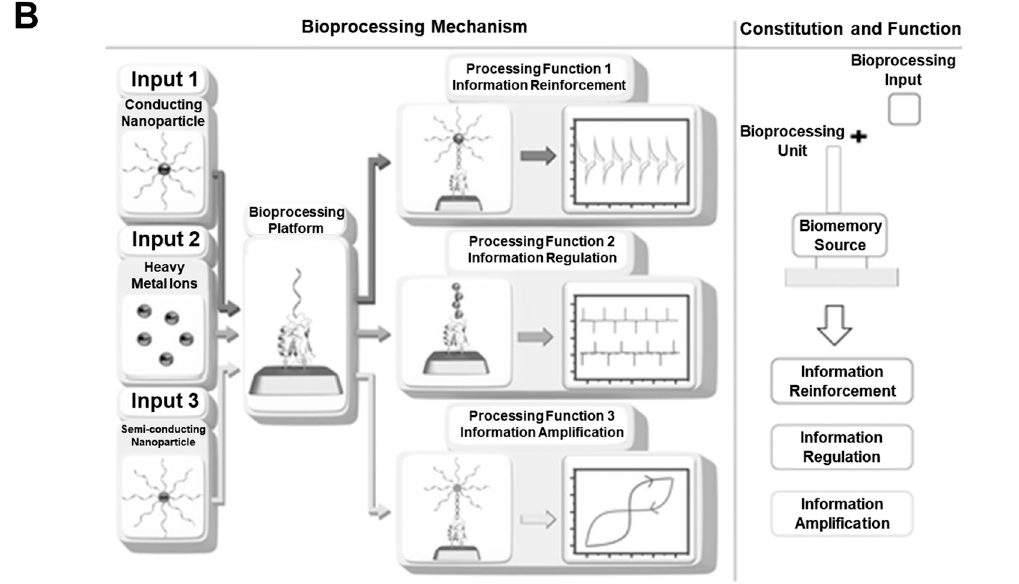
Figure 7. Bioprocessors. ( A ) Schematic image and electrophoresis results of DNA-based bioprocessor composed of six stages, including the first stage as problem encoder, the second stage as DNA solution bay for converted DNA preparation, the third as mixing controller for mixing and ligase of appropriate DNA sequences to make the template of DNA duplexes, the fourth as solution purifier for isolation of optimal DNA template from impurities such as the incompletely hybridized oligonucleotides or enzymes, the fifth as PCR amplifier for amplification of optimal DNA template which is the optimal route, and the sixth as gel electrophoresis to acquire the final electrophoresis data for solving optimal-route-planning problems, ( B ) Schematic image of bioprocessor based on bionanohybrid materials to demonstrate the specific processing functions including the electrochemical signal reinforcement, regulation, and amplification. (Reproduced with permission from [82], published by American Chemical Society, 2015, and reproduced with permission from [31], published by John Wiley and Sons, 2013).